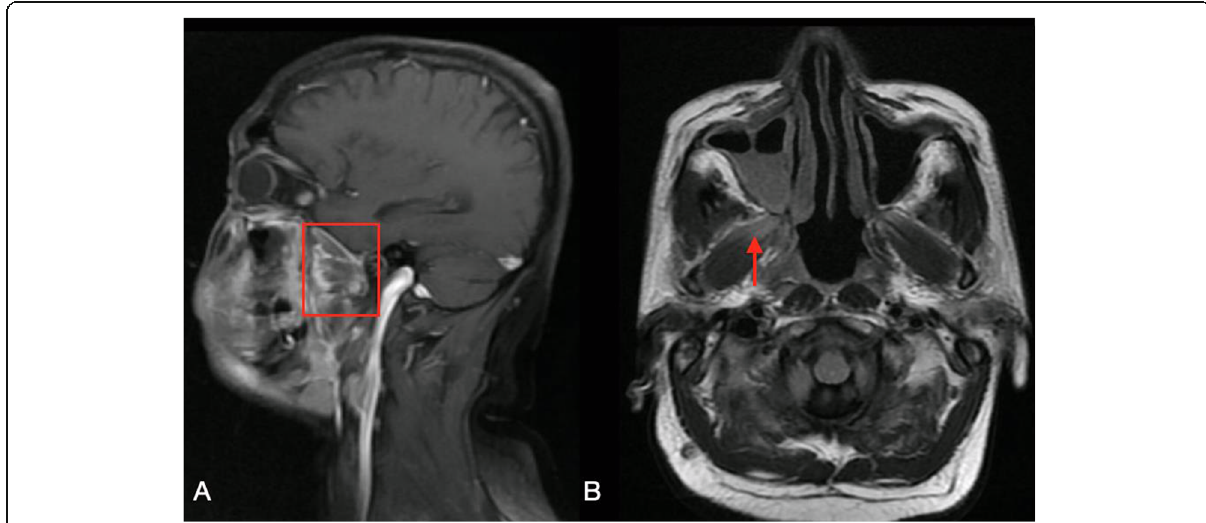
Fig. 7 T1 sagittal FS + contrast ( A ) and axial FLAIR ( B ) study there is enhancement of right medial and lateral pterygoid muscles (red box) and subcutaneous soft tissue component anterior to maxilla on right side. Inflammation and involvement of the right pterygoid muscles (red arrow) and parapharyngeal space below it